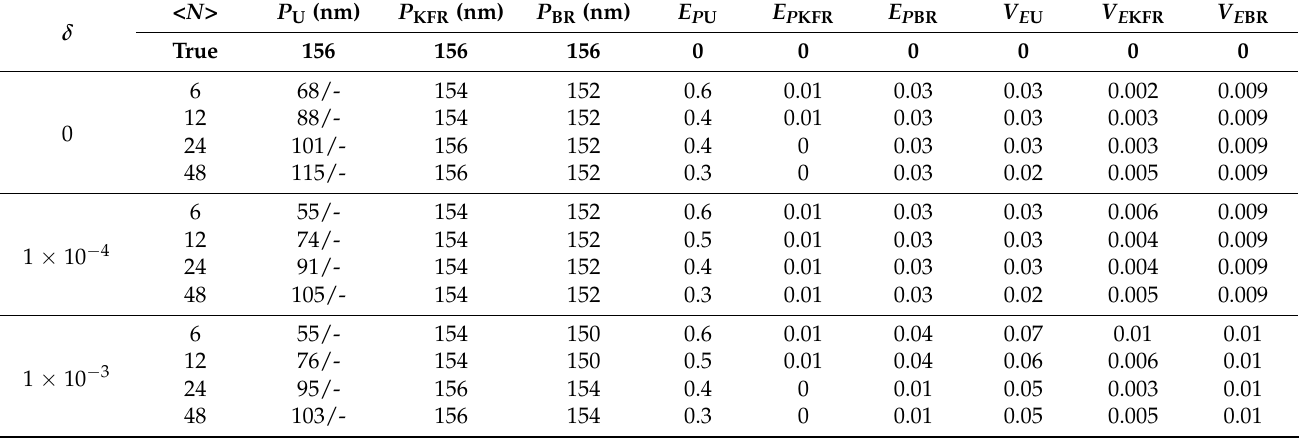
Figure 5. PSD recovered by the KFR method for a 156 nm unimodal sample at number concentrations of < N > = 6, 12, 24, 48, and different levels of noise. ( a ) 0, ( b ) 10 − 4 , ( c ) 10 − 3 , ( d ) 10 − 2 , and ( e ) 10 − 1 noise levels. Table 3. Performance parameter values for the recovery of the 156 nm PSD by using three